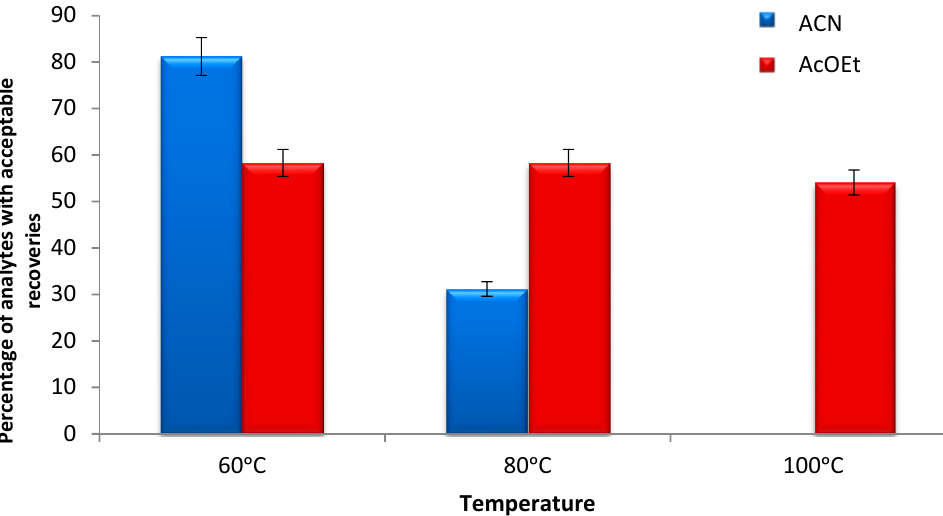
Figure 2. Percentage of pesticides and mycotoxins with acceptable recoveries in the range 70–120% when using acetonitrile and ethyl acetate as extraction solvents, at different temperatures (60, 80, 100 °C).